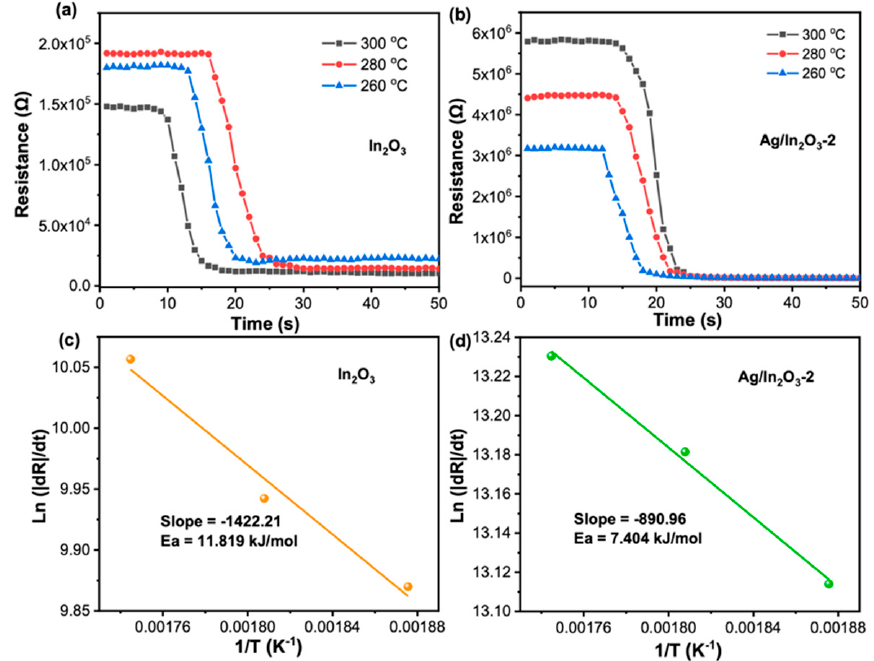
Figure 9. The transient resistance change of ( a ) In 2 O 3 and ( b ) Ag/In 2 O 3 -2 as exposure to 20 ppm TEA at different temperatures, and derived Arrhenius-type plots of ( c ) In 2 O 3 and ( d ) Ag/In 2 O 3 -2.